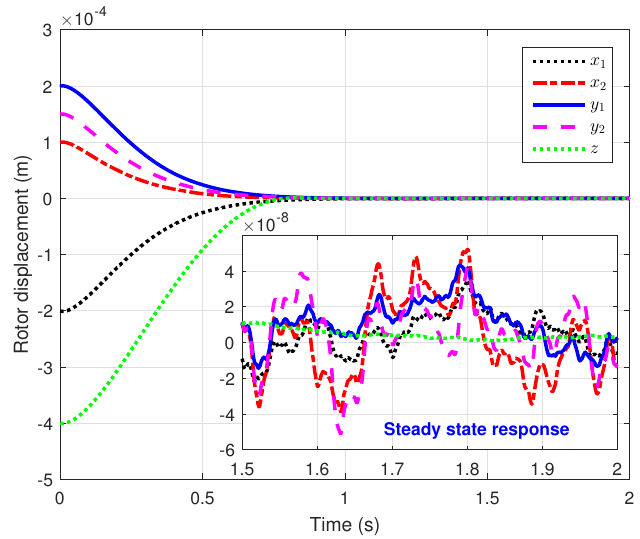
Figure 2. The responses of rotor positions under AITOSMC. The time-varying control inputs response of the AITOSMC is presented in Figure 3. All the components of the control input reaches to the steady-state in 0.8 s. However, the three components of the control input, i.e., i x , i x , i z settles down to the vicinity of 2 1 origin, and i y , i y approaches to the steady-state value of 0.18 A, as shown in Figure 3. 2 1 Although the rotor positions settles down to the nominal values in 0.8 s, the proposed input currents are applying the electro-magnetic force for negating the effects of uncertainties and disturbances present in the system for the whole simulation time. Moreover, it can be seen from the zoomed-in response of steady-state in Figure 3 that the chattering is significantly reduced under the proposed scheme. The chattering converges to the bound of approximately 3 × 10 − 3 A.